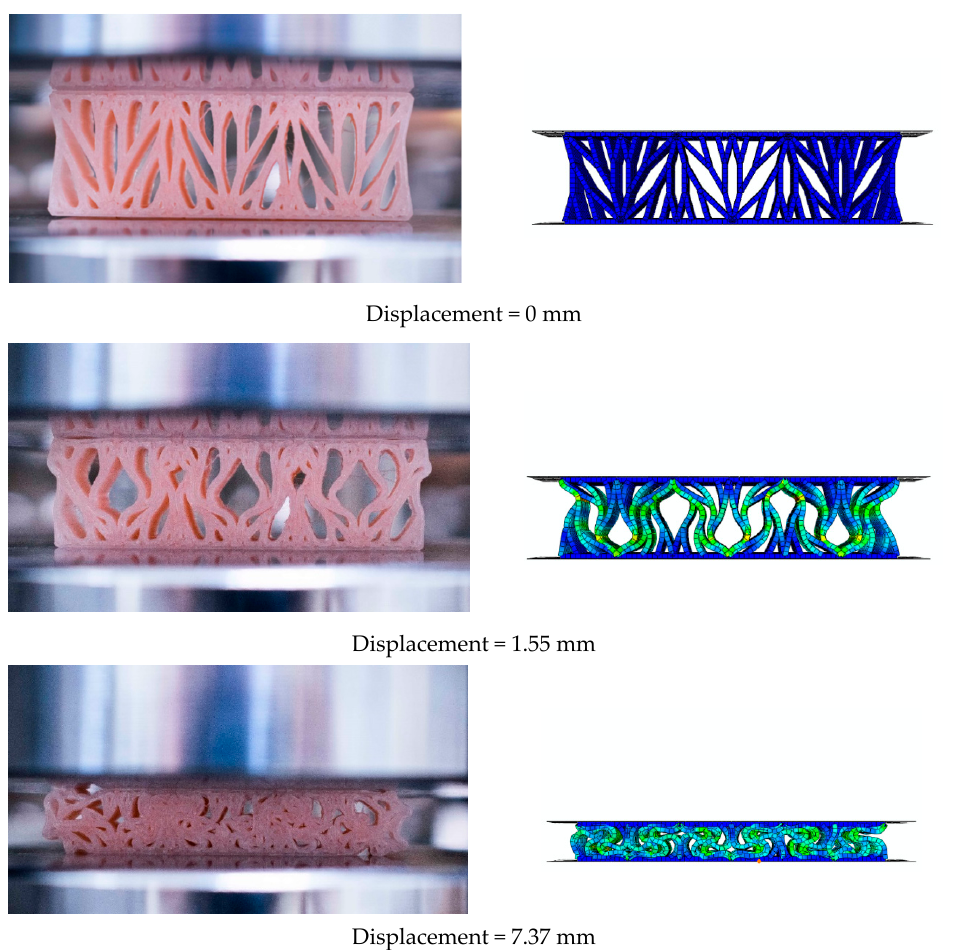
Figure 9. The deformation of 15 degrees TPU model under quasi-static compress: ( a ) The model at the initial position; ( b ) Compressive displacement equal 1.55 mm; ( c ) Compressive displacement equal 7.37 mm.